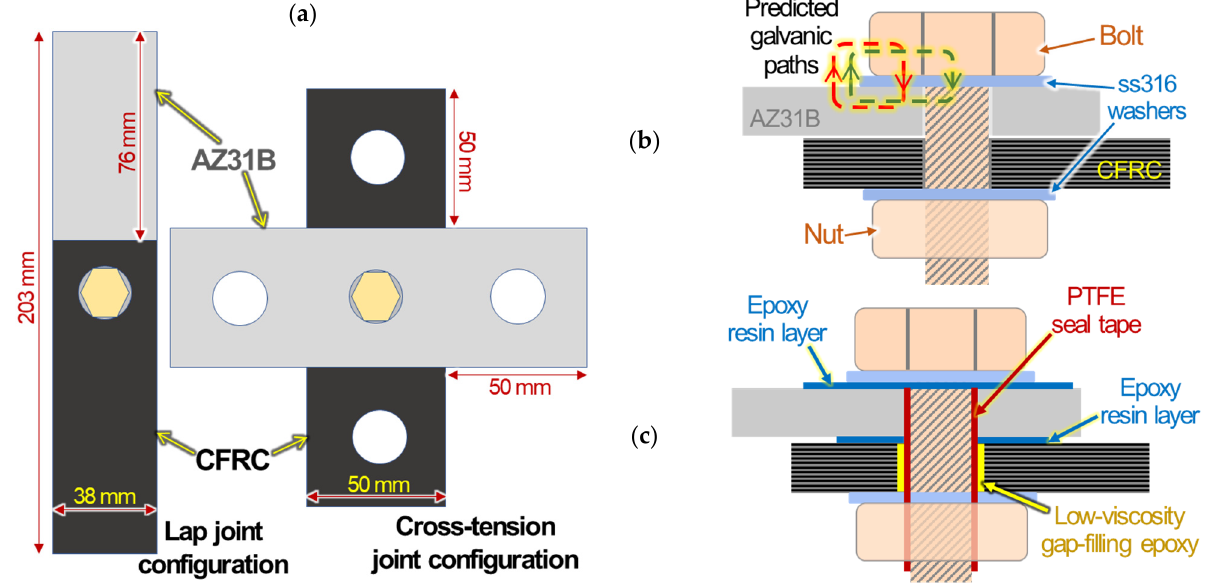
Figure 2. Schematics of ( a ) lap and cross-tension joints of AZ31B and CFRC. The cross sections of bolted AZ31B and CFRC are also schematically described for ( b ) bare joint with predicted galvanic paths (red and green dot arrows) and ( c ) polymer-insulated joints.